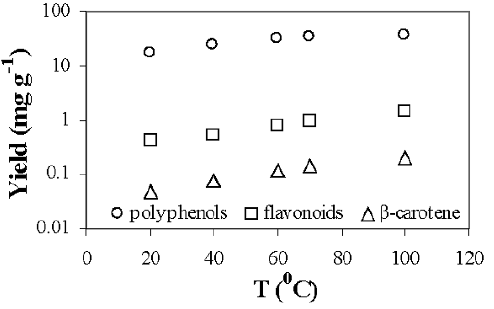
Figure 3. Yield at different temperatures, 1 hour water extraction.